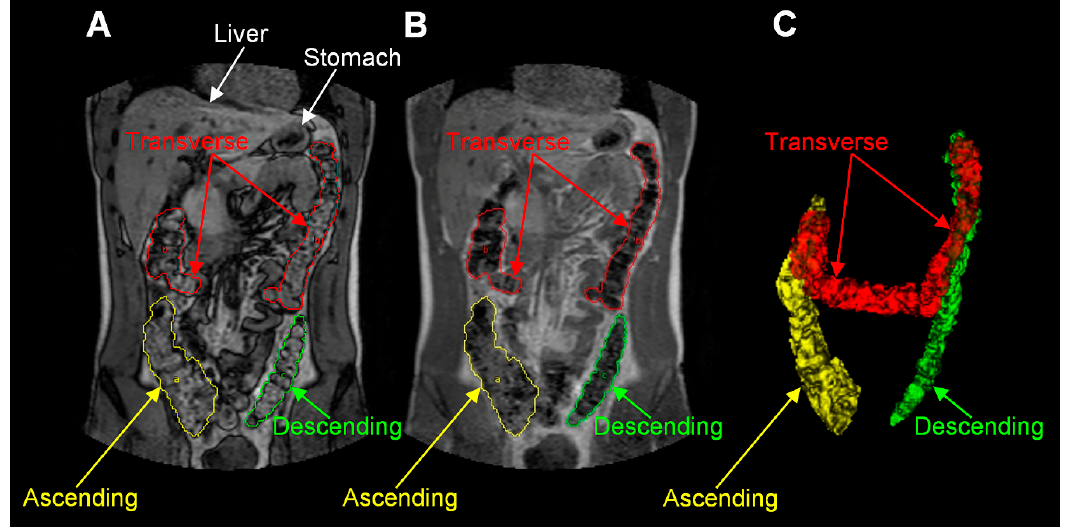
Figure 3. MRI images for colonic anatomy. ( A , B ) are different out of phase and in phase water and fat dual-echo imaging and ( C ) is a 3D reconstruction. Reproduced from [33], Blackwell Publishing LTD, 2013 with permission.